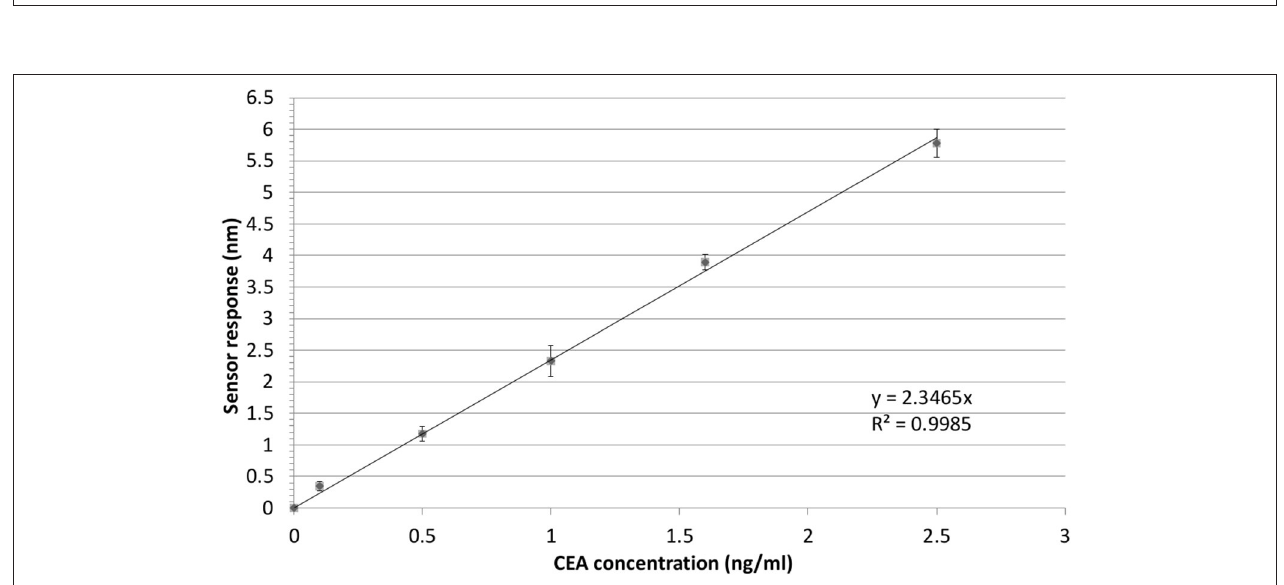
FIGURE 6 | Specific SPR sensor responses to S-NPs (A) and Ab 2 -NPs (C) and relative non-specific SPR sensor response (RNS) to S-NPs (B) and Ab 2 -NPs (D) as a function of LDPN. The data were calculated as the mean values of SPR sensor responses at the equilibrium taken from at least 3 measurements. Measurements were performed in buffer (PBS BSA ) after the biosensor surface was exposed to blood plasma.